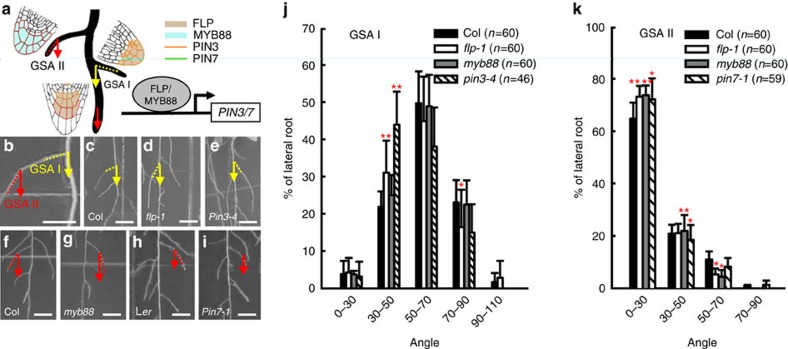
Coordination of FLP and MYB88 in setting lateral root GSAs.(a) Diagram showing the roles of FLP and MYB88 in the lateral root gravitropic response. PIN3 and PIN7 transcript levels are regulated by FLP and MYB88 through the cis-regulatory elements located within the PIN3 and PIN7 promoter regions. (b) The gravitropic response of lateral roots was measured by the angles between the lateral root and the gravity vector, GSA I and GSA II. (c–e) flp-1 lateral roots (d), similar to pin3-4 (e), display a smaller GSA I than Col (c). myb88 lateral roots (g) have a smaller GSA II than Col (f). pin7-1 (in a Ler background) lateral roots (i) have a smaller GSA II than Ler (h). (j) Distributions of lateral root GSA I (formed during Stage I–II). Similar to pin3-4, the flp-1 mutants show stronger gravitropic responses than wild-type lateral roots, resulting in a smaller GSA I. However, the myb88 displays a GSA I comparable to that of wild-type lateral roots. (k) Distribution of lateral root GSA II (formed during Stage III–IV). Similar to pin7-1, myb88 shows a smaller GSA II than wild-type lateral roots. Asterisks in j,k indicate significant differences (Student's two-tailed t-test; *P<0.05 and **P<0.01; three individual experiments; n, represents the number of lateral roots scored for each genotype). Bars represent mean values with s.d. The KS test was also performed and the cumulative distribution plots are shown in Supplementary Figs 7 and 8. Scale bars, 2 mm.